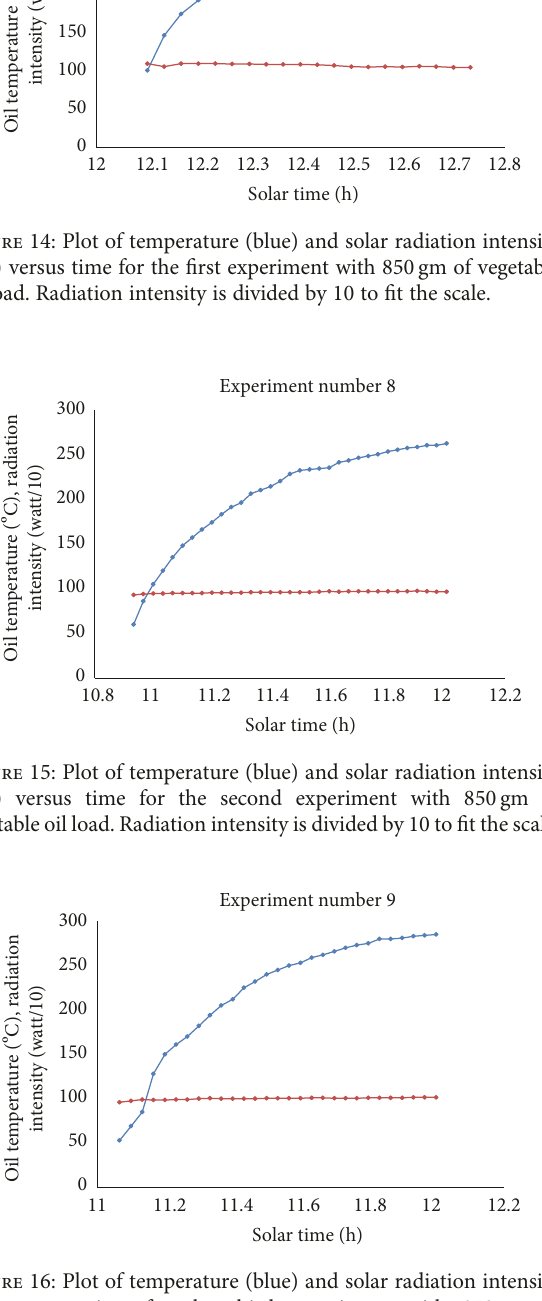
Figure 13: Plot of temperature (blue) and solar radiation intensity (red) versus time for the third experiment with 4 kg of water load. Radiation intensity is divided by 10 to fi t the scale.